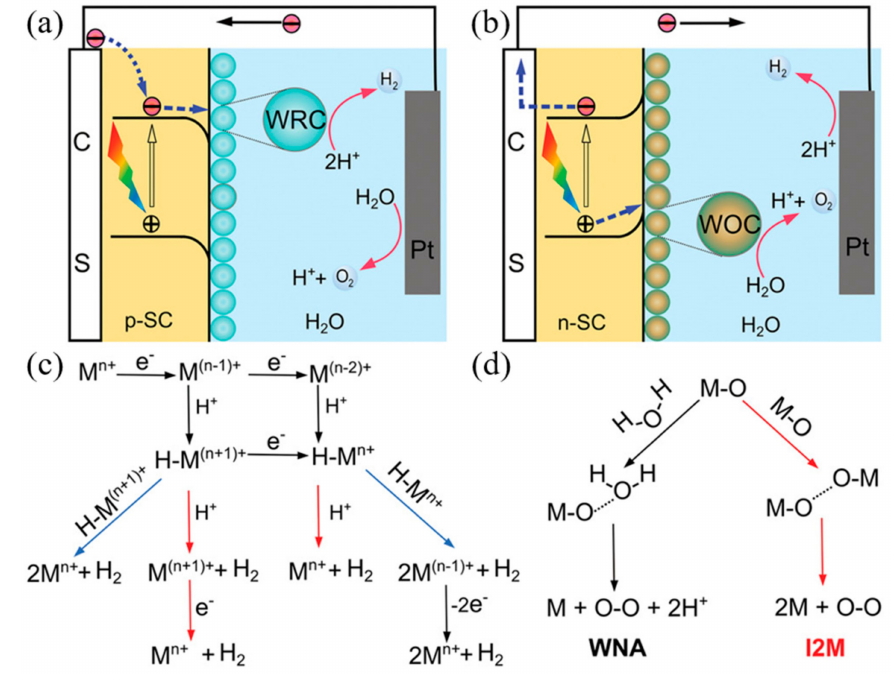
Figure 2. Photoelectrochemical processes involved in ( a ) water reduction and ( b ) water oxidation. ( c ) Proposed mechanistic pathways for H 2 generation at a metal center of M n + . ( d ) Two